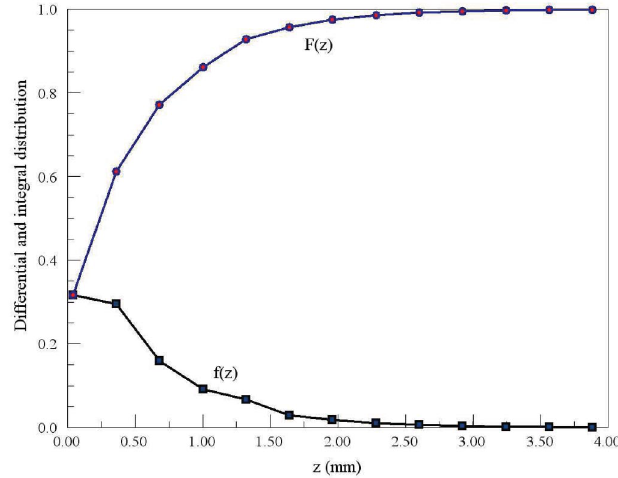
FIG. 9. (Color) Radiation spot size for the CRAD baseline simulation, determined by back-projecting photon trajectories. Photon probability density function f (cid:3) z (cid:4) and cumulative distri- bution function F (cid:3) z (cid:4) as a function of distance from the anode